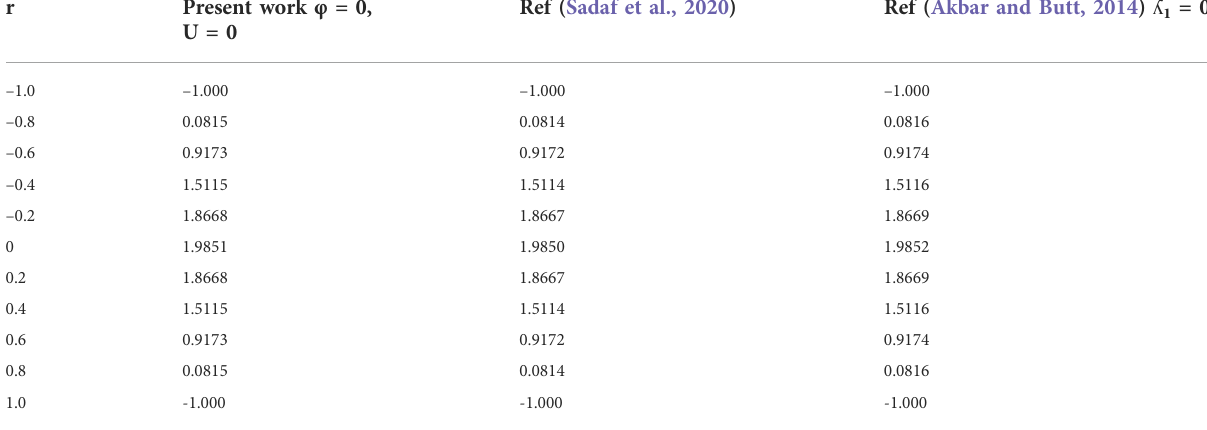
TABLE 2 Comparison of the present results with the existing